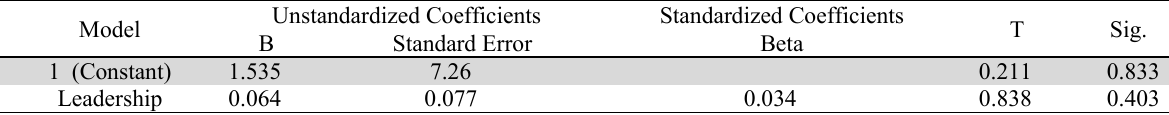
Coefficient leadership, job satisfaction and performance